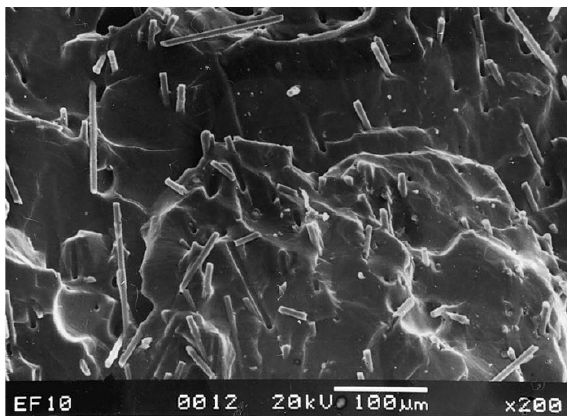
Figure 3. SEM images showing ( a ) the distribution of SCF within the EVA matrix. Reproduced with permission from Das et al. [75], Copyright 2000, Elsevier Ltd .